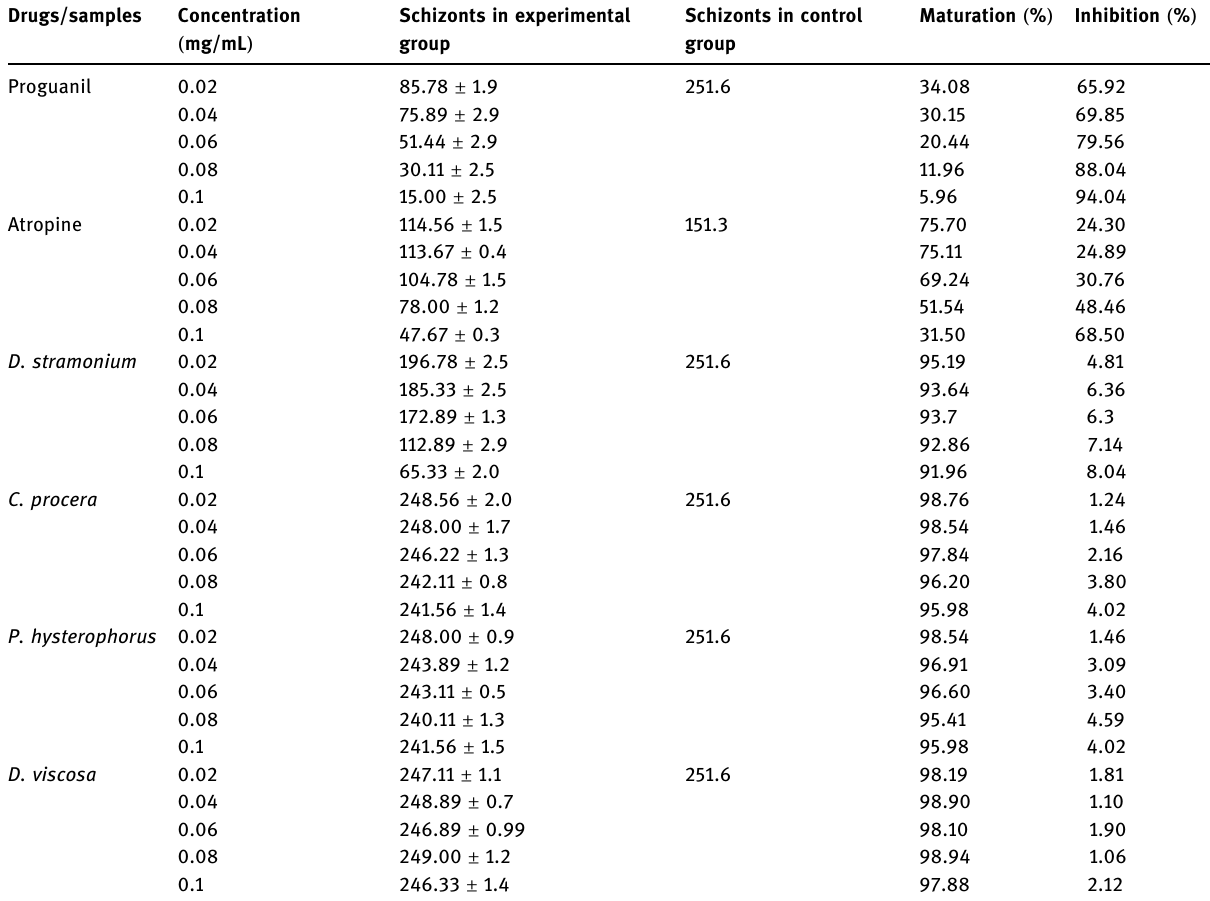
Table 1: Inhibition percentage of proguanil, Atropine, D. stramonium , C. procera , P. hysterophorus , and D. viscosa crude extracts against P. vivax